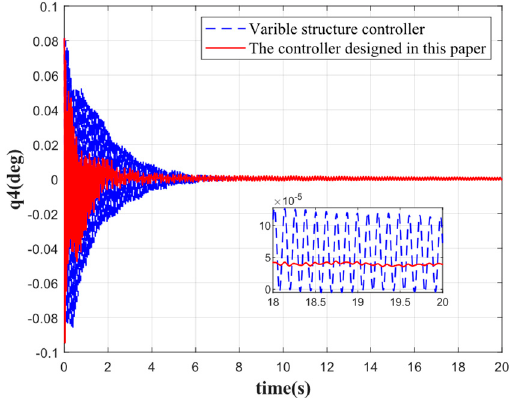
Figure 7. Third ‐ order elastic vibration mode without external interference.